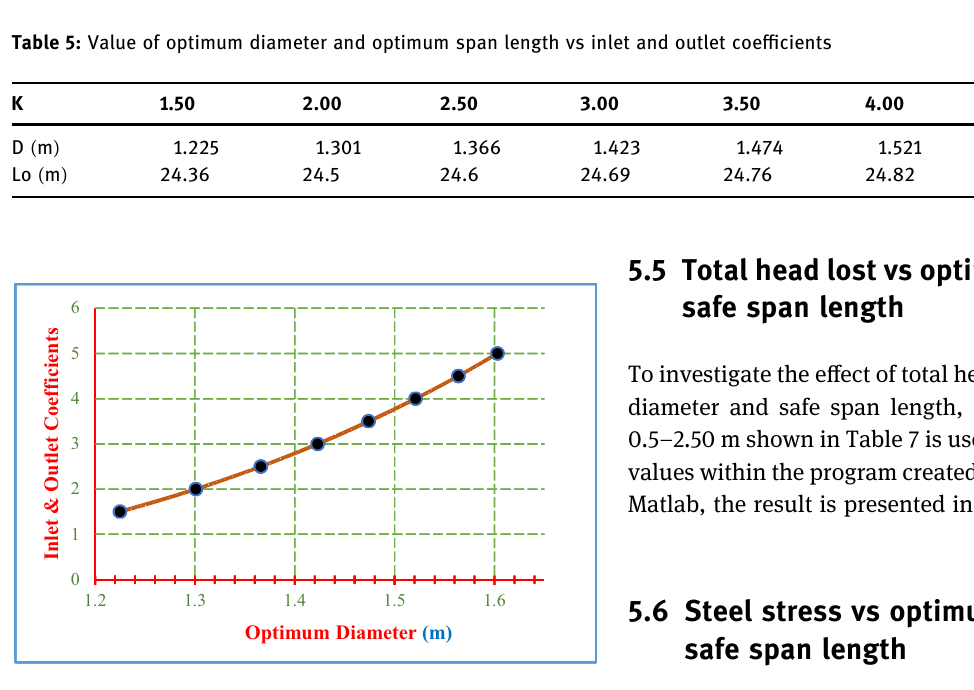
Figure 7: Optimum diameter vs inlet and outlet coe ffi cients.